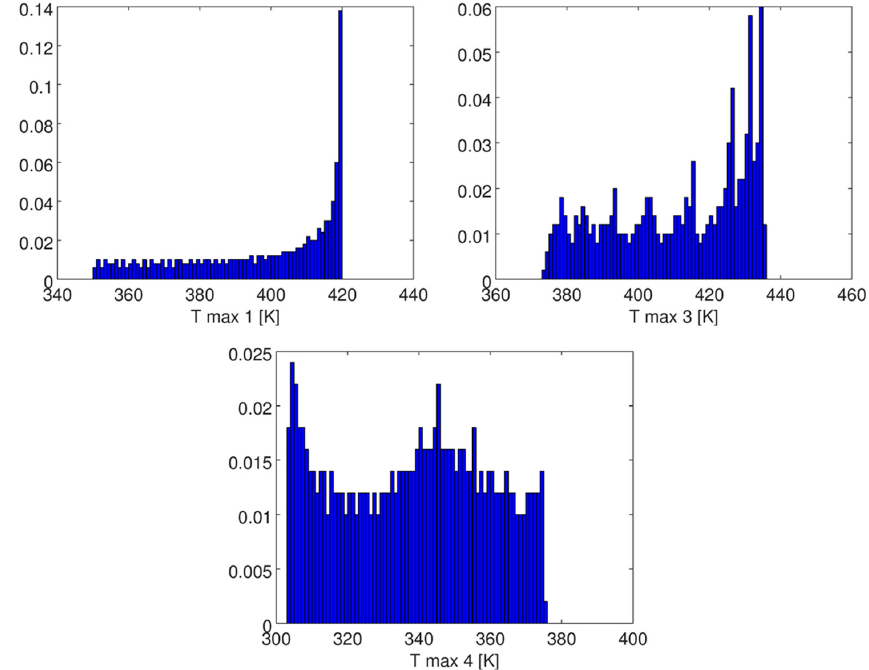
Figure 14. Pdf of maximum temperature with uniform input distribution of vf .